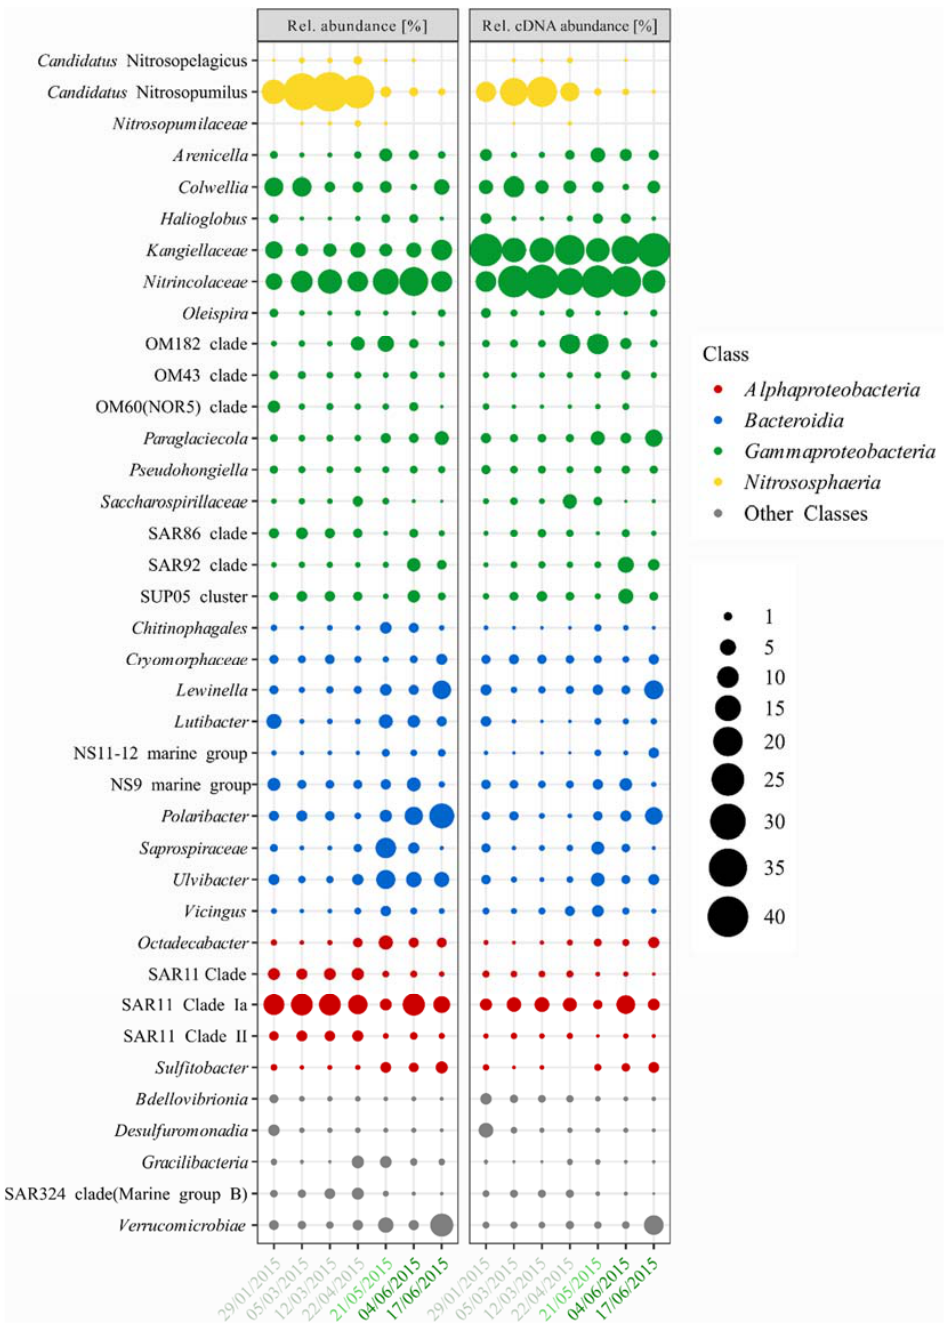
Figure 3. Bubble plot of the most abundant bacterial and archaeal taxa during the N ‐ ICE2015 expe ‐ dition, which constitute at least 80% of the total community per sample. The plot shows the distri ‐ bution of 16S rRNA genes (rel. abundance) and RNA the distribution of 16S rRNA copies (rel. cDNA abundance) of the different taxonomic groups. The color of the dates indicates the season (light green = winter, green = spring, and dark green = summer) and the ice algae bloom (dark green). The Nitrososphaeria , dominated by Cand . Nitrosopumilus increased from initial 13.3% rel. abundance in January towards 37.9% of rel. abundance in March and decreased to 0.6% in late June (Figure 3). This is reflected by an increase in cell abundance from 4.7 × 10 5 cells mL − 1 in January to 7.9 × 10 3 cells mL − 1 in March, the highest abundant taxa of the whole dataset, before decreasing to <3.5 × 10 2 cells mL − 1 in spring and summer (Figure 4).